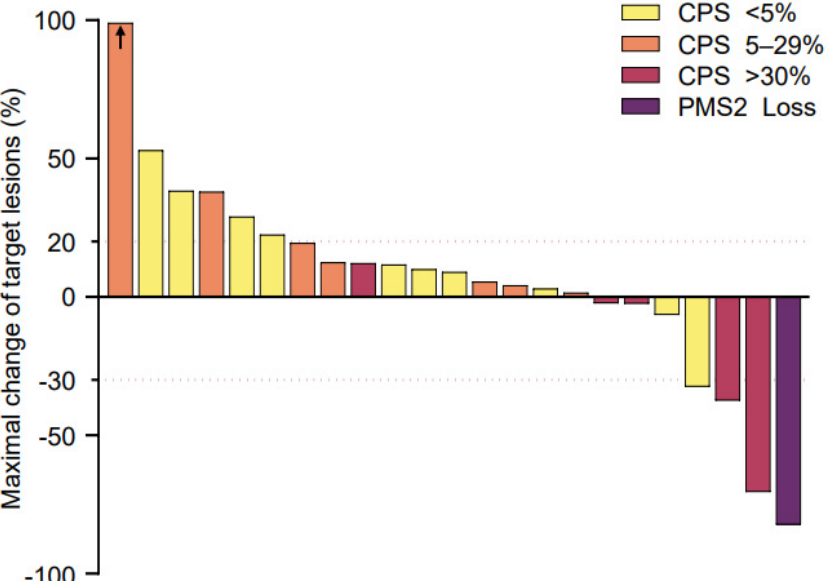
Figure 2. Best changes in the sizes of the target lesions from the baseline for 23 patients in the phase 2a trial. The change in target lesions was calculated as the ratio to the baseline diameters measured in computed tomography (CT) images. The yellow bars indicate patients with a combined positive score (CPS) < 5%, orange bars CPS 5–29%, and red bars CPS > 30%. The purple bar indicates a patient who lost PMS2 . The arrow indicates that the patient had a 169% increase in the size of the target lesion according to Response Evaluation Criteria in Solid Tumors (RECIST) version 1.1, and of the scale for the figure is inaccurate. The upper red dashed line indicates a 20% increase in the size of the target lesion from the baseline, and the lower red dashed line indicates a 30% decrease in the size of the target lesion from the